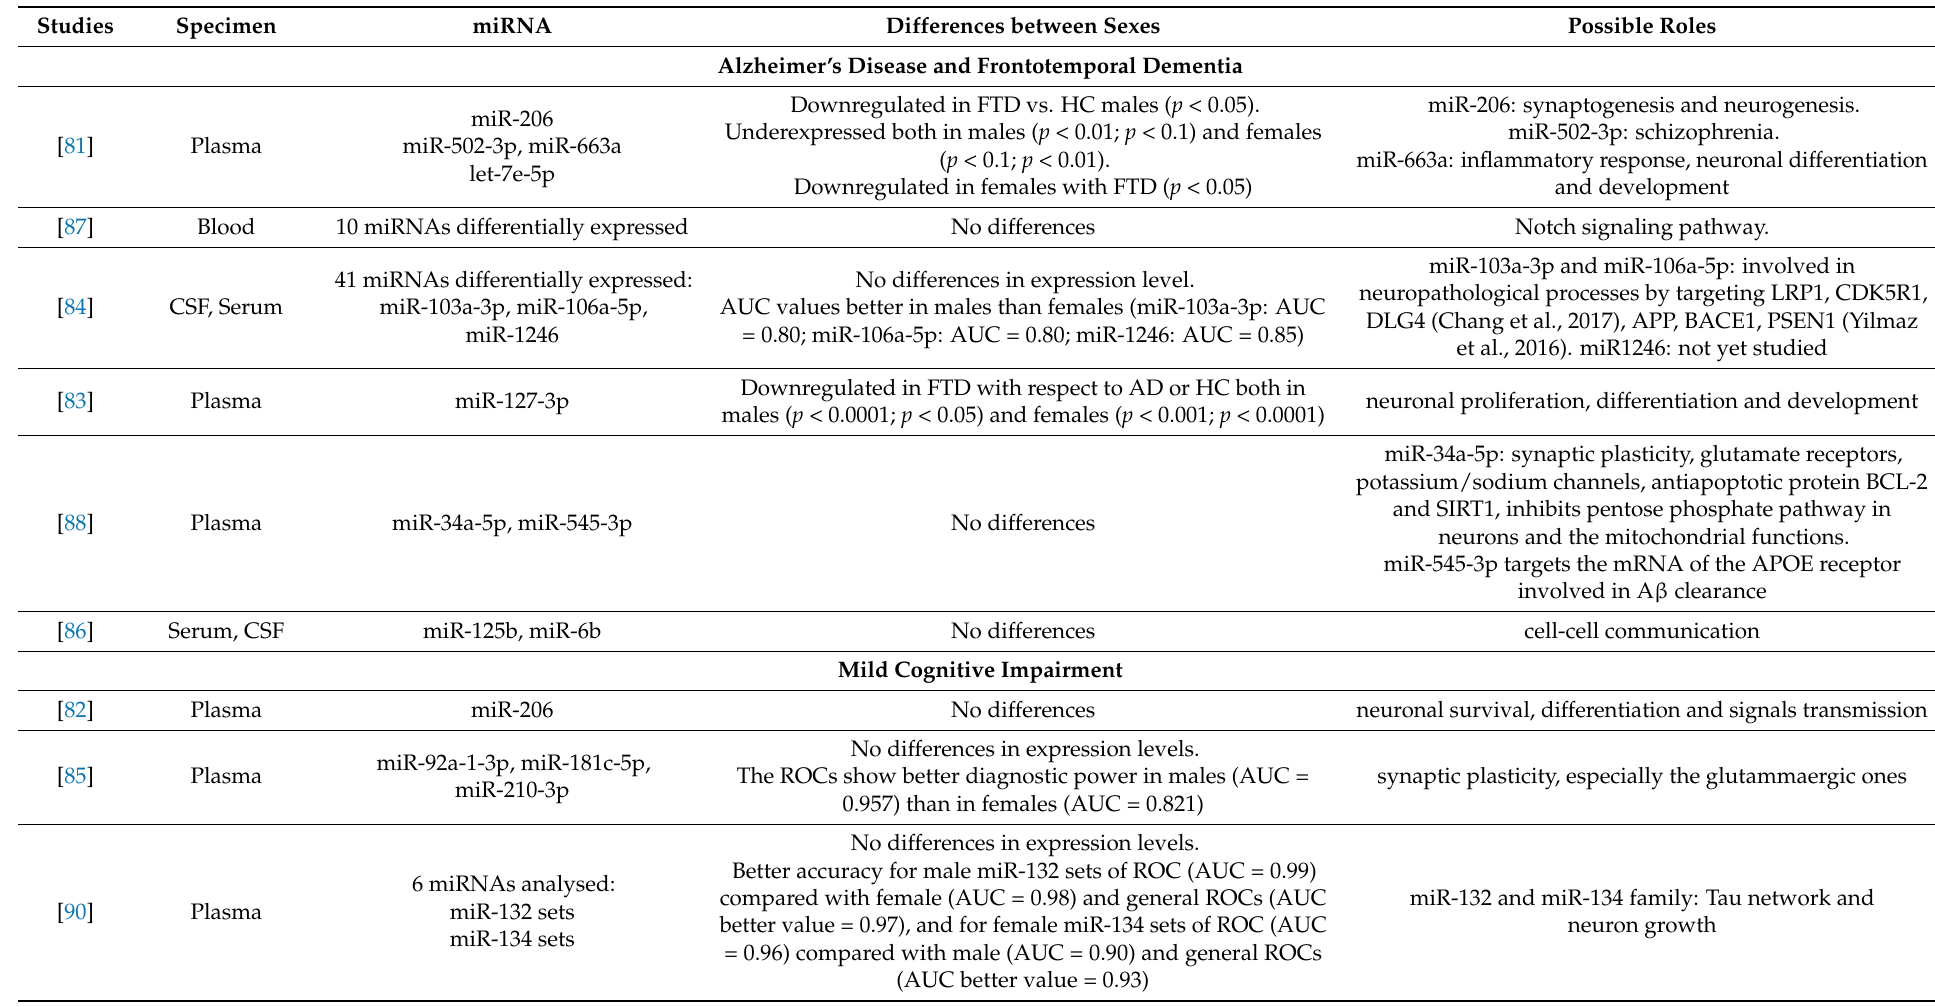
Table 2. Summary of differences between sexes in miRNA levels from studies including patients with